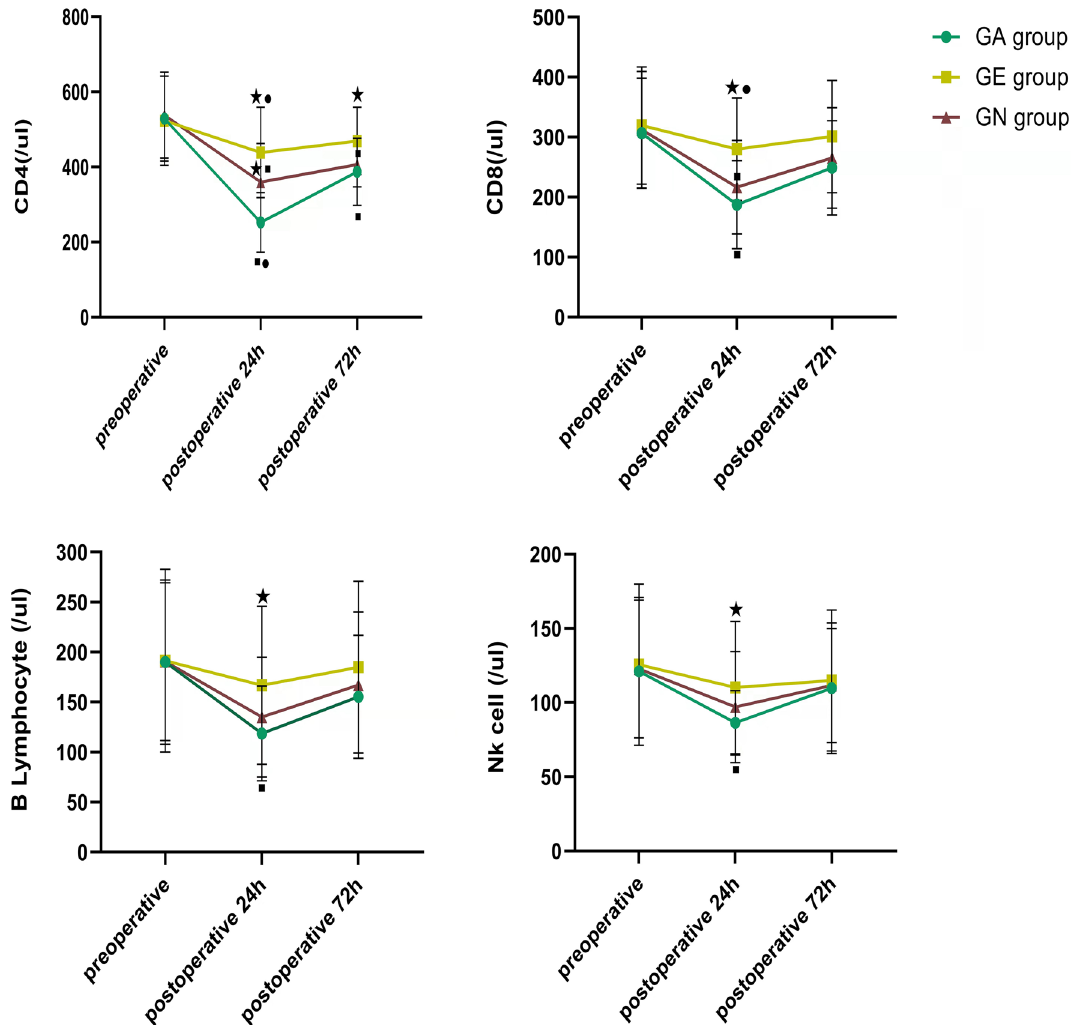
Figure 1. Comparison of immune indexes among the three groups. ★ : Compared with the GA group, P < 0.05; ■ : Compared with the GE group, P < 0.05; ● : Compared with the GN group, P < 0.05.